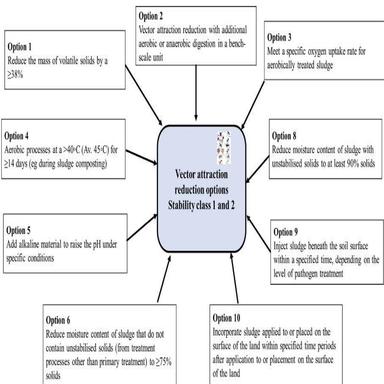
Vector attraction reduction options applicable to Stability class 1 and 2 only. Adapted and modified from and.